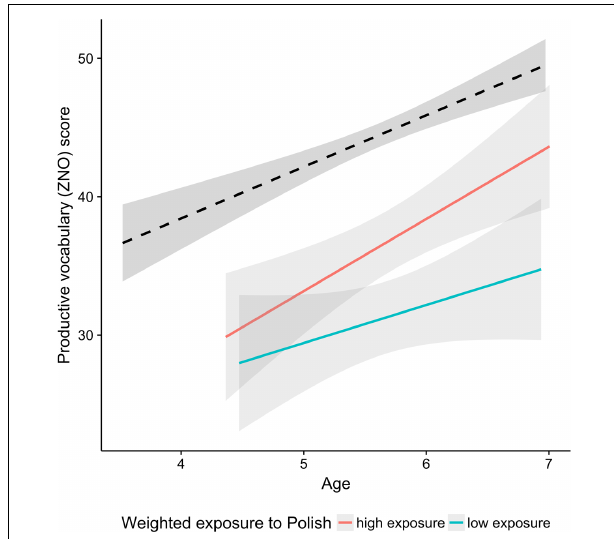
FIGURE 4 | Scores in the productive vocabulary test plotted as a function of age. The black dashed line indicates the monolingual group and the two colored lines correspond to the bilingual group. Red and aqua correspond to the median split on exposure to L1 Polish. The median split was performed for visualization purpose only.